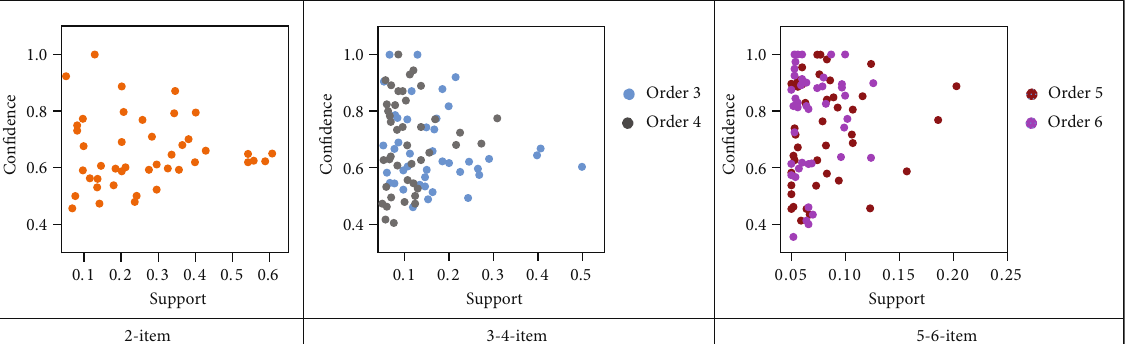
Figure 5: Two-key plots for crash events.